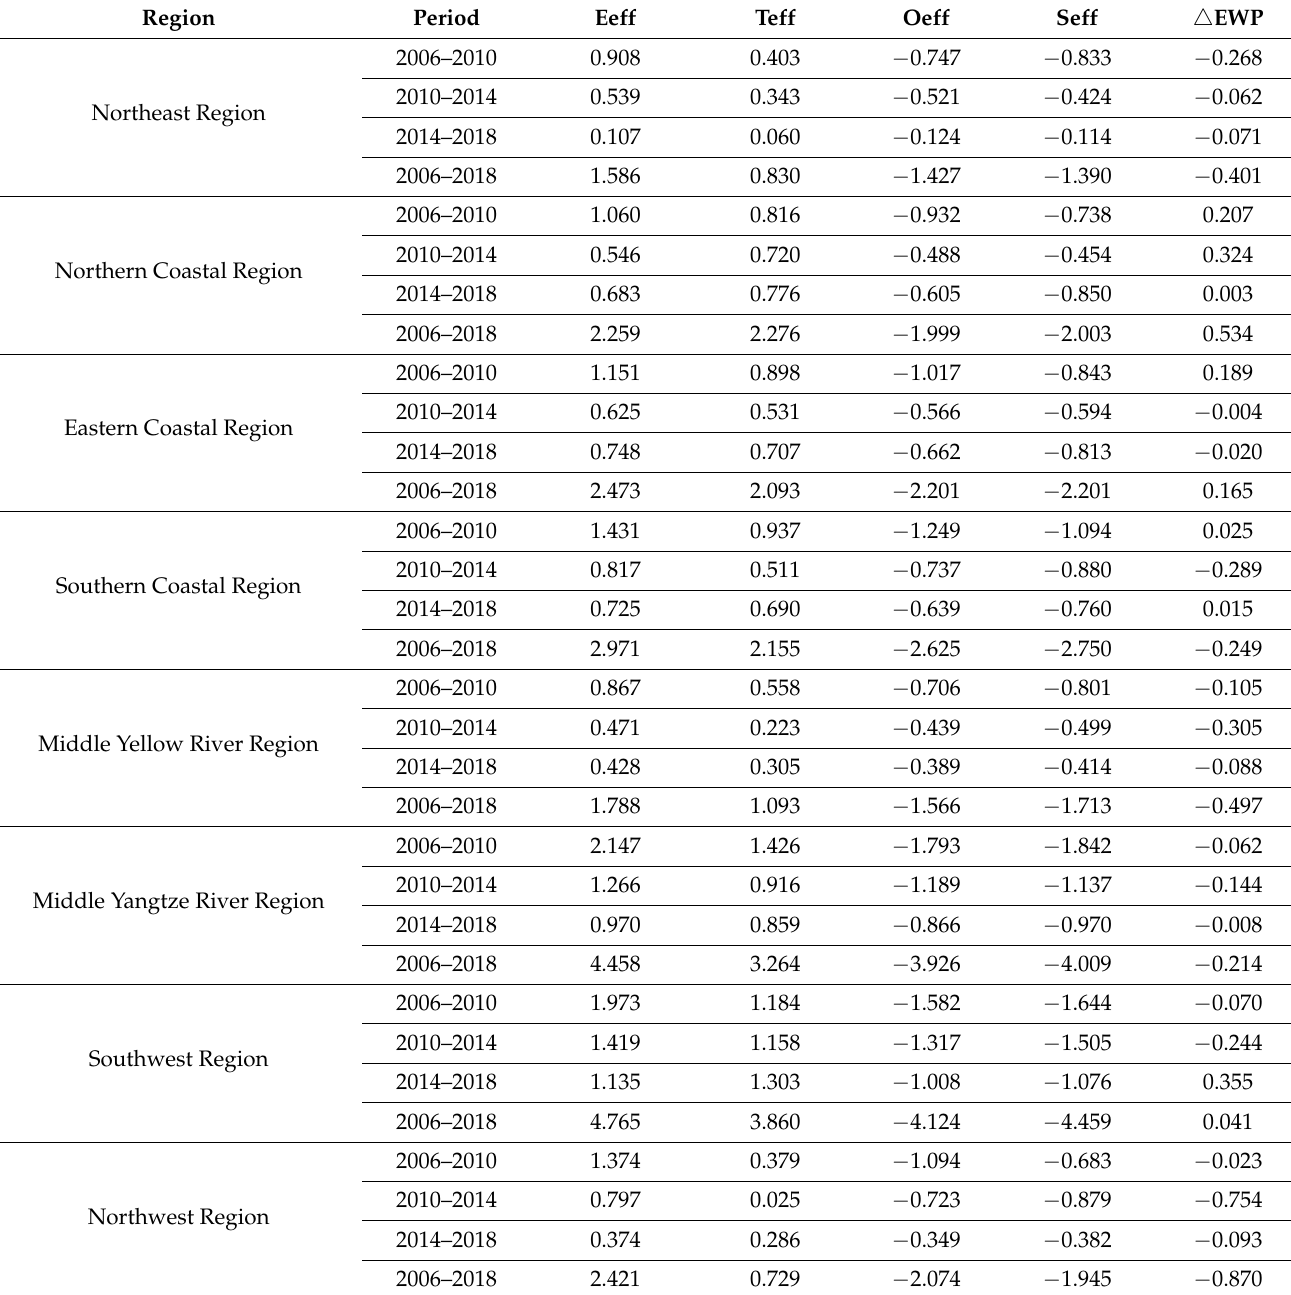
Table 9. Driving effects of EWP in eight economic regions: 2006–2018.